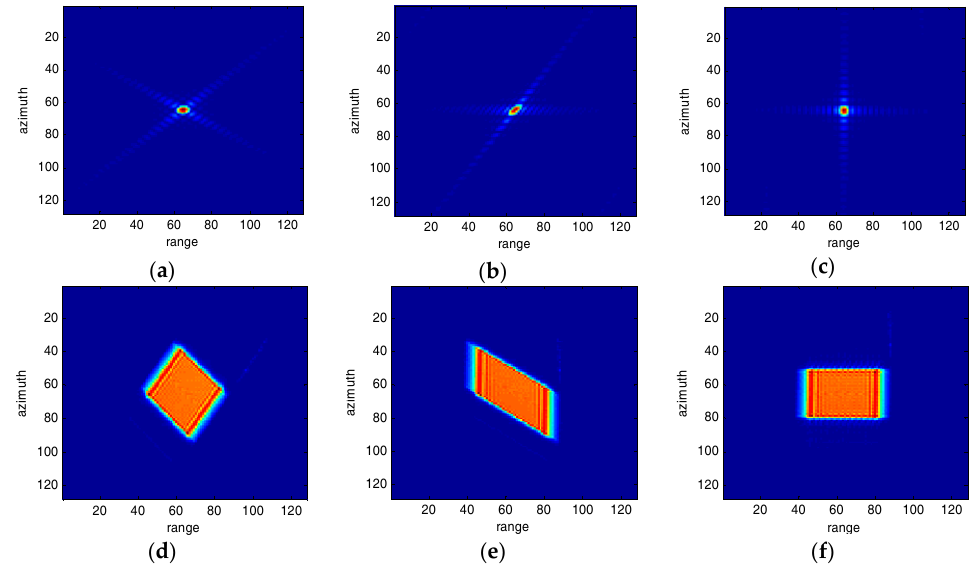
Figure 6. The squint SAR images ( a ) Squint angle 40° SAR image; ( b )Range sidelobes corrected; ( c )Range and azimuth sidelobes corrected; ( d ~ f ) are the 2-D spectrum images for ( a ~ c ), respectively. 4.3. Sidelobe Reduction for Squint SAR Images Sidelobe reduction for squint SAR images includes the following steps.